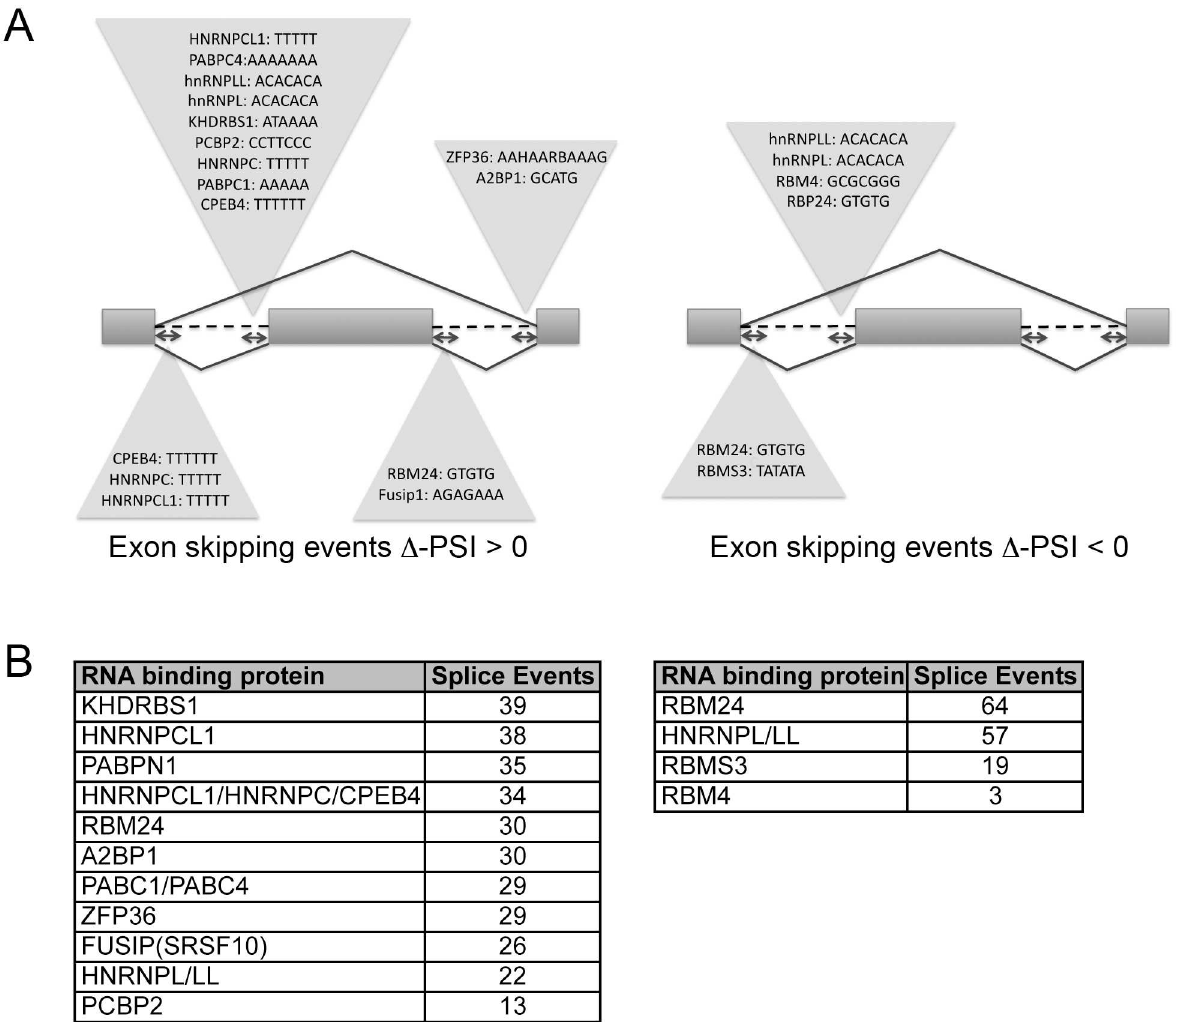
Fig 5. RNA binding protein motifs at sites of alternative exon splicing. A) The upstream and down-stream intronic regions for each alternatively spliced exon were interrogated for the presence of pentameric RNA bindingprotein motifs. No significant RBP recognition sites were identifiedwithin exons or in the up- or downstream exon. B) The total number of recognition motifs for each RNA binding protein is displayed. Only hnRNP-L/LL and RMP4 bindingmotifs were present at both retainedand skipped